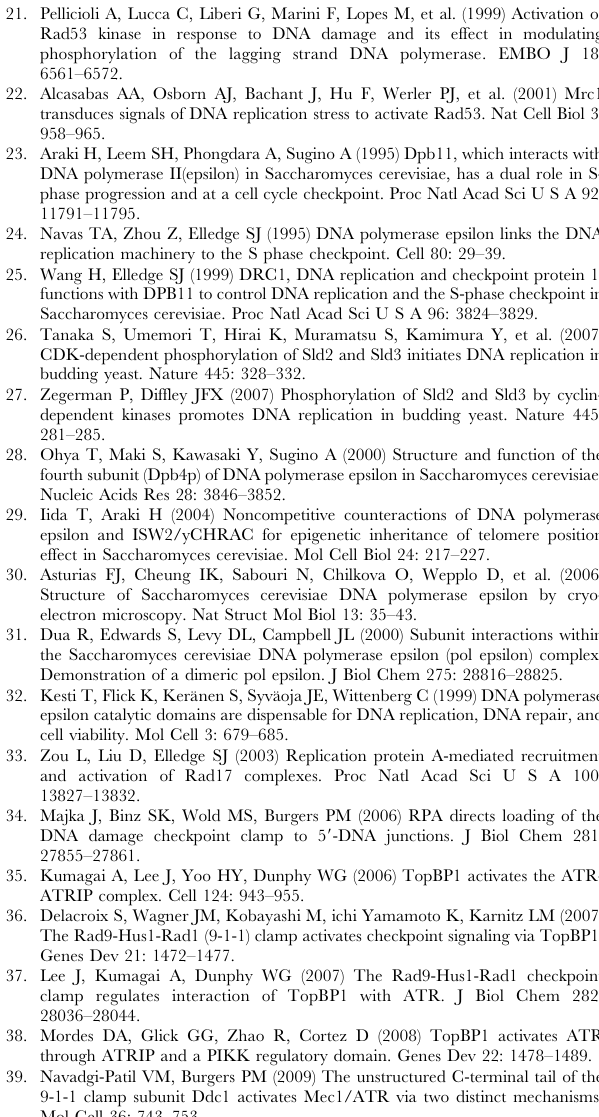
lower panel. Figure S4 Hydroxyurea does not elicit a DNA damage response in the drc1-1 and dpb4 D mutants. (A) Strains K699 (WT), Y799 ( drc1-1 ), YAN21/8d ( ddc1 D ), YFP218/1a ( ddc1 D drc1-1 ) and YFP62/1d ( ddc1 D dpb11-1 ) were grown to mid-log phase, synchro- nized in G1 with a -factor and released into fresh medium supplemented with 200 mM HU. After 90 min Rad9 phosphor- ylation was assayed by SDS-PAGE and western blotting. (B) Strains K699 (WT), YFP167/1a ( dpb4 D ), YAN21/8d ( ddc1 D